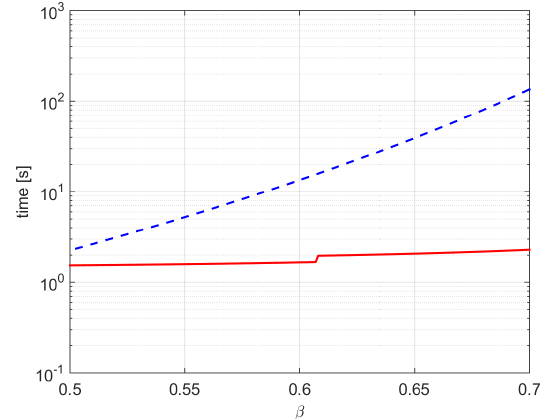
Figure 4. Comparison of the computational burden required by the standard RANSAC for the linear algorithm for the estimation of the essential matrix (blue dashed line) with that of the method proposed in section 4. (red solid line).